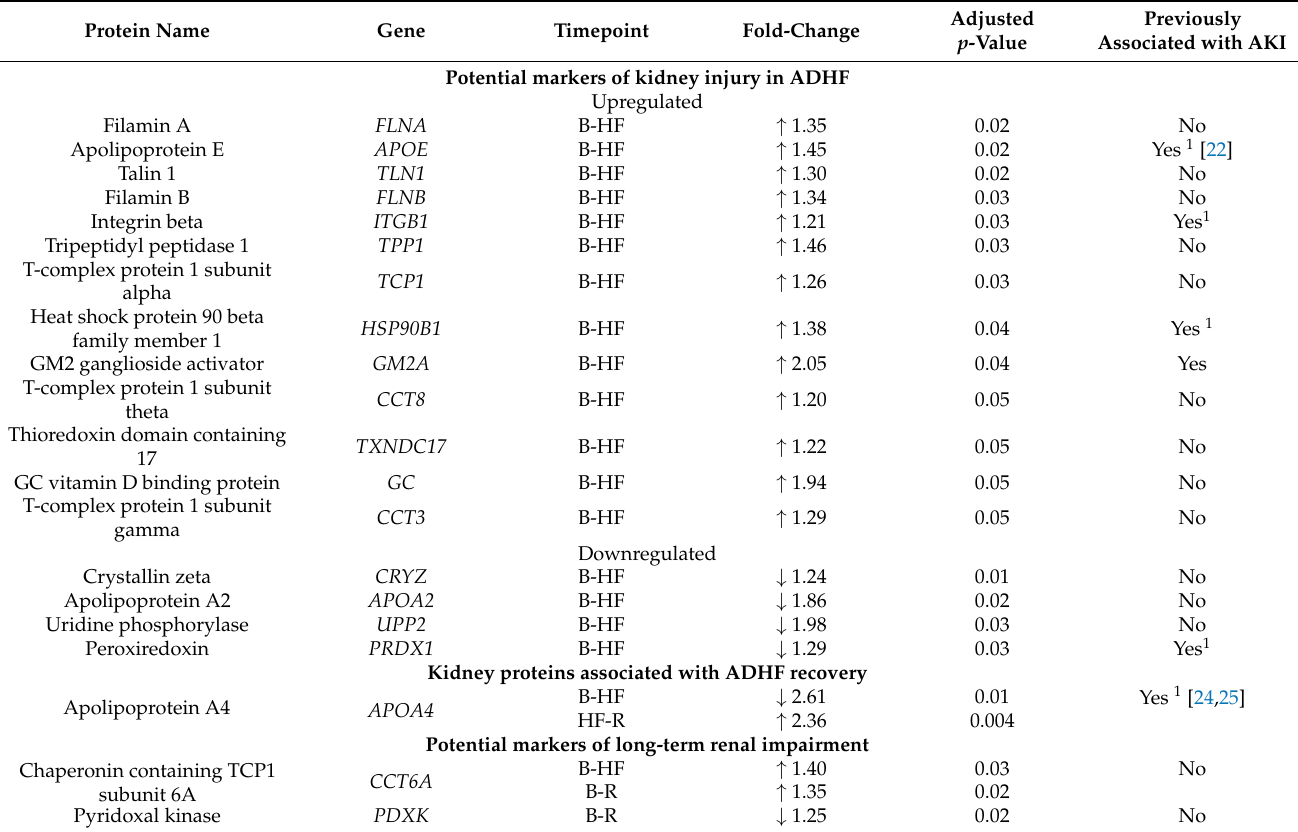
Table 2. Proteins with a fold-change ≥ 1.2 and Benjamini–Hochberg adjusted p -values < 0.05 that are potentially detectable in the plasma, serum, or